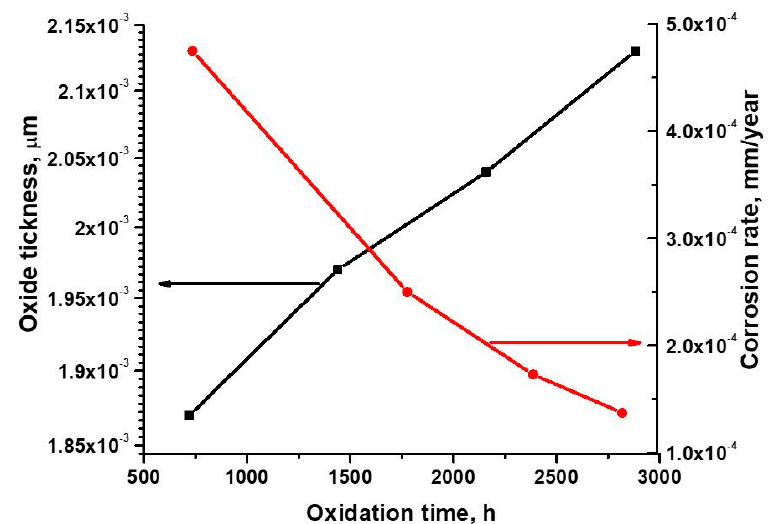
Figure 2. Oxide thickness and corrosion rate dependence on exposure time in deaerated supercritical static water of the 310 H samples.